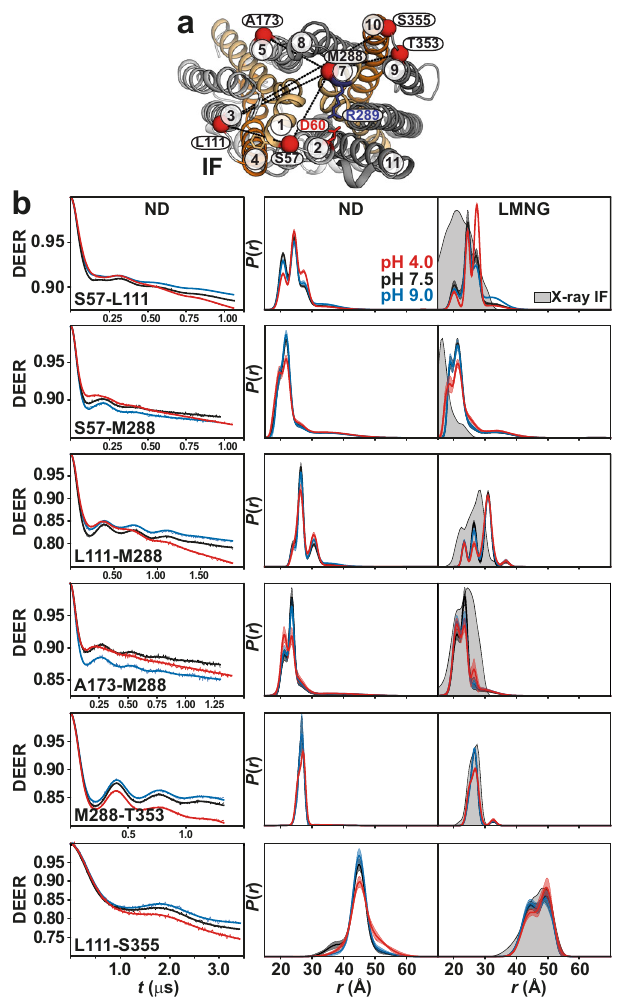
Fig. 5 | Proton binding stabilizes an outward-closed conformation. a Spin label pairs(redspheres)aredepictedontheperiplasmicsideoftheIFcrystalstructure.A salt bridge between Asp60 and Arg289 keeps the transporter in a closed con- formation. b Raw DEER decays and fi ts (left) are presented for the distance dis- tributions P ( r ) in lipid nanodiscs (middle) and in LMNG micelles (right). The distributions predicted from the IF crystal structure are shaded pairs between NTDand CTD(e.g.,M84-S386, S25-S386;Fig. 7a). Onthe